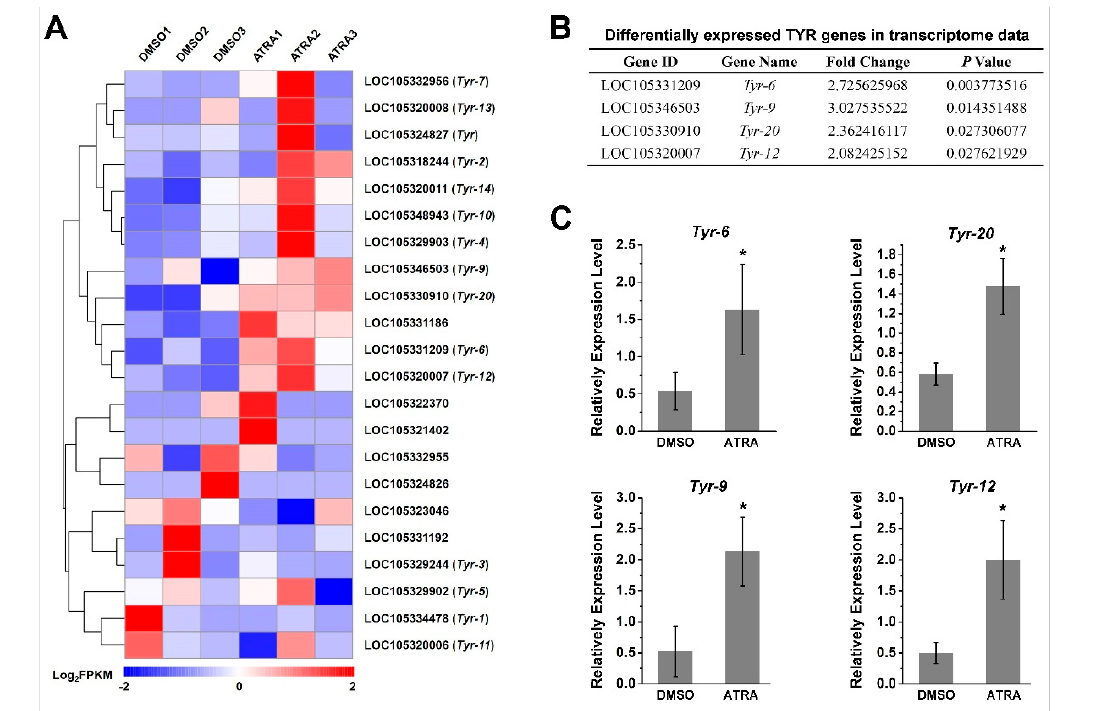
Figure 2. Expression of TYR gene after ATRA treatment. ( A ) The expression profiles of 22 TYR genes identified in transcriptome sequencing; ( B ) differentially expressed TYR genes in transcriptome data (fold change ≥ 2, p values < 0.05); ( C ) verification of TYR gene expression by RT-qPCR. Relative expression of TYR genes after ATRA treatment. Error bars represent means of three replicates ± SD (standard deviation, n = 6). (* p < 0.05; Student’s t test). Tyr (LOC105324827) and Tyr-8 ( Trp2 , LOC105344040) are tyrosinase genes related to